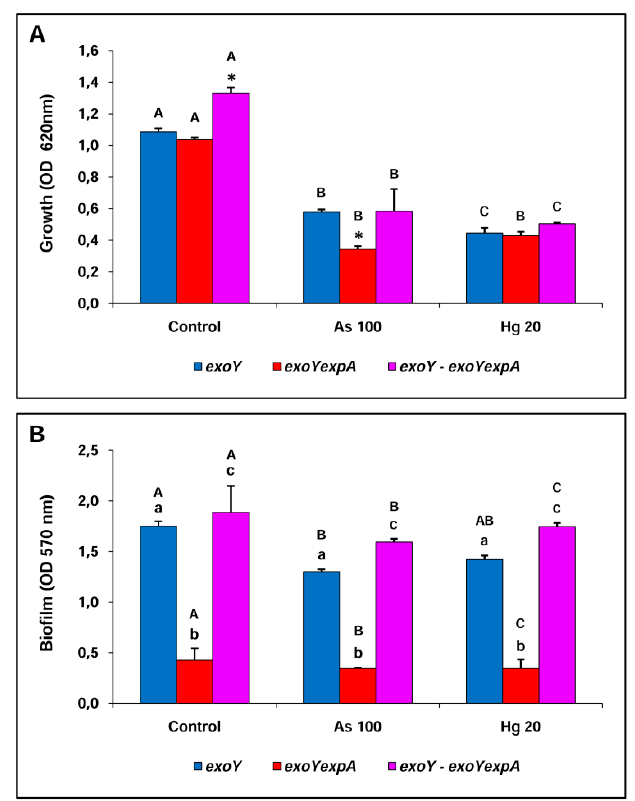
Figure 4. Bacterial growth ( A ) and biofilm formation ( B ) of individual and co-culture S. meliloti strains in control and exposed to metal conditions. ( A ) Bars marked with * indicate statistic differences among individual or co-culture strains for the same condition, whereas different capital letters indicate statistic differences between conditions for a given strain according to Fisher’s LSD test ( P < 0.05); ( B ) Different small letters indicate statistic differences among individual or co-culture strains for the same condition and different capital letters indicate statistic differences between conditions for a given strain according to Fisher’s LSD test ( P < 0.05).